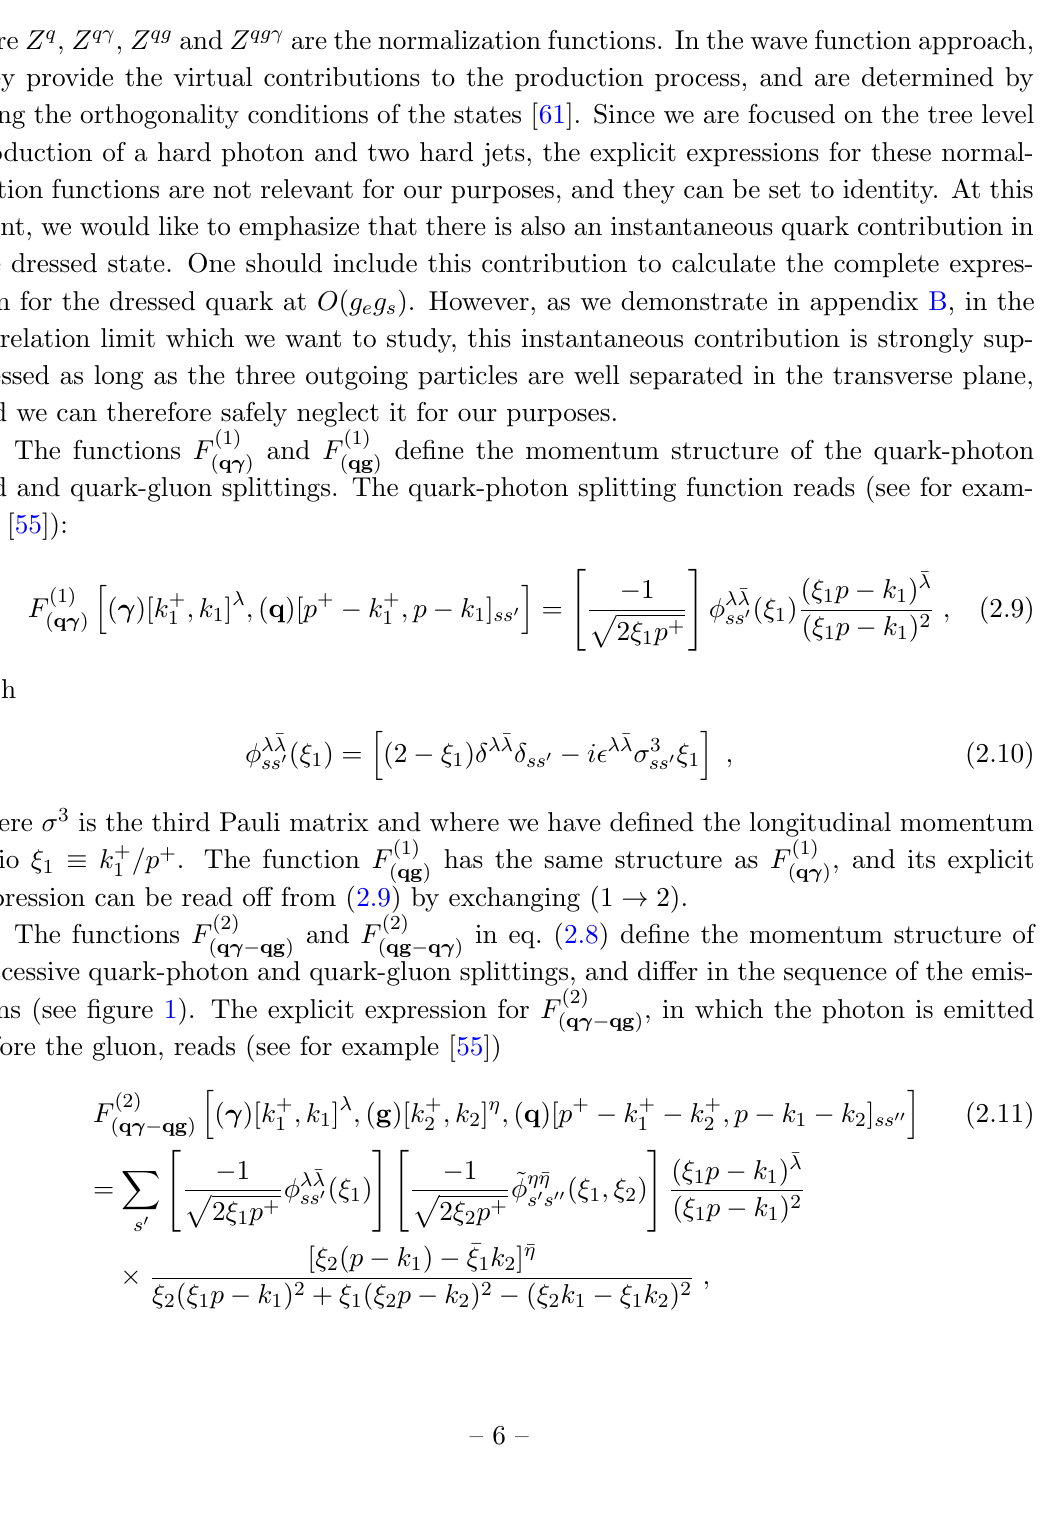
Figure 1 . The dressed quark state to order O ( g e g s ), with the two possible orderings of the photon resp. gluon emission by the